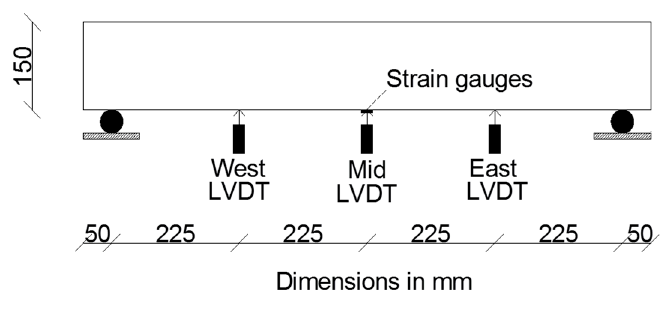
Figure 5. Instrumentation detailing of the tested beams.